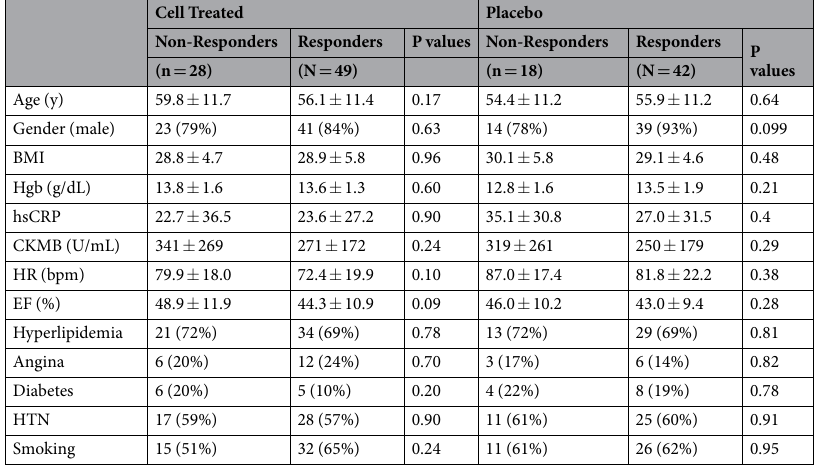
Table 1. Clinical features of responders ( Δ EF > 0) and non-responders ( Δ EF > 0) treated with either cell BM- MNCs or placebo. Values are mean ( ± SD) or number of subjects